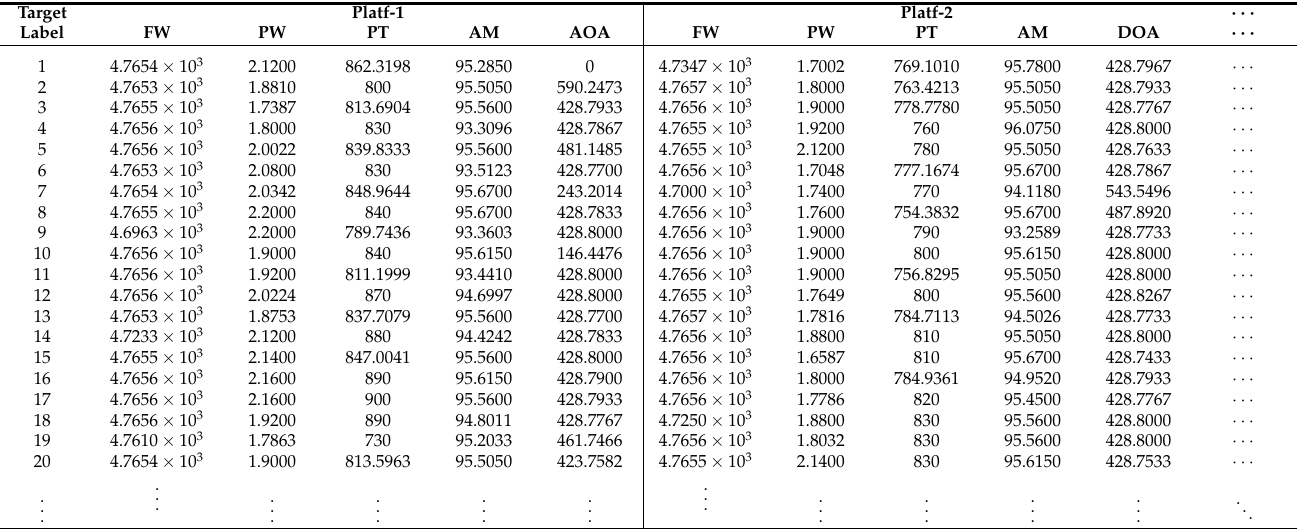
Table 9. Results recovered by Algorithm